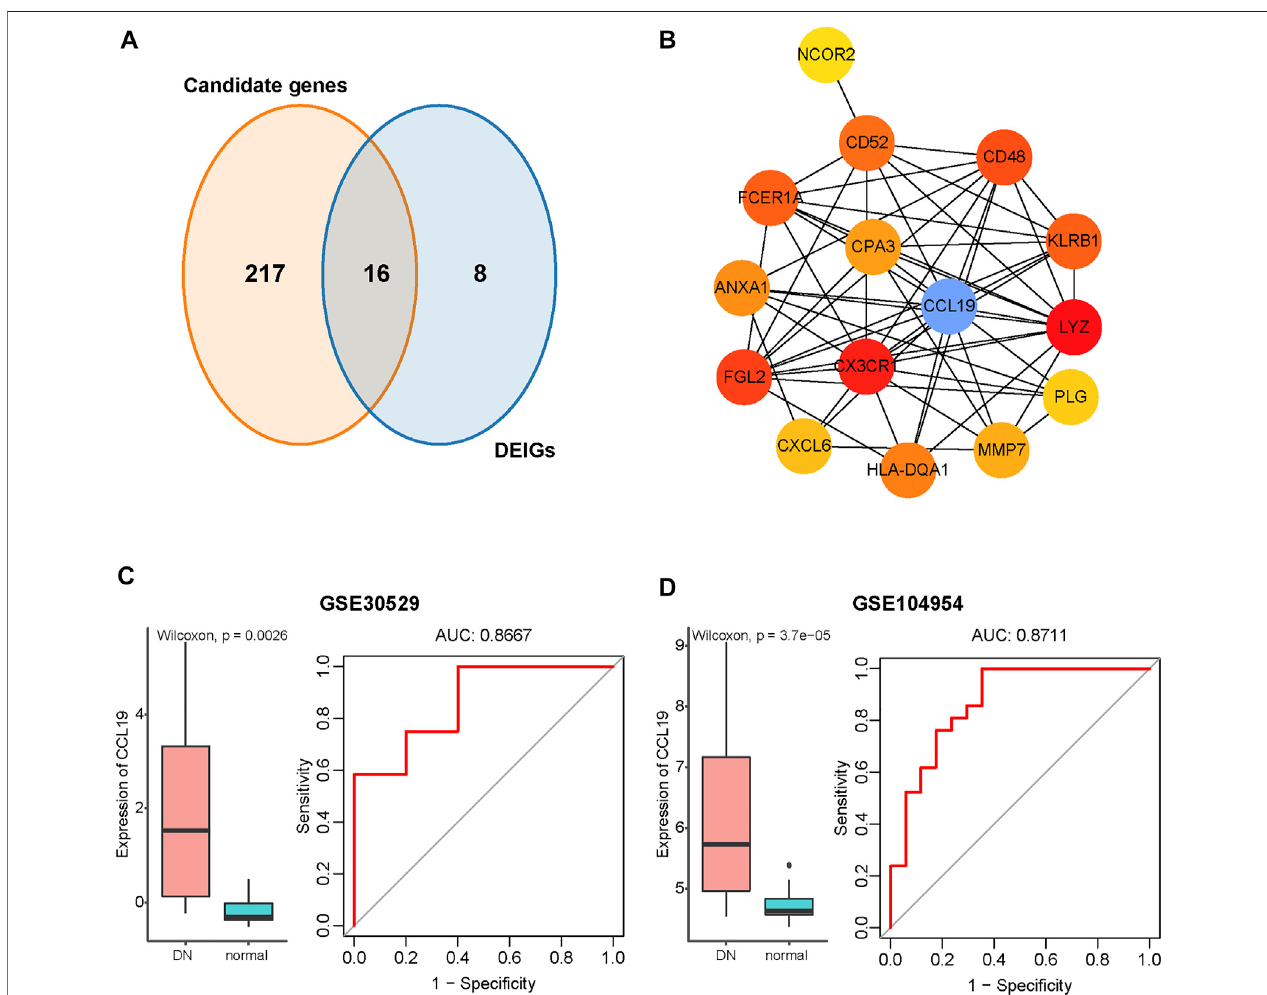
FIGURE 5 | Identi fi cation of CCL19 as a hub immune gene in DN and veri fi cation in the GSE30529 and GSE104954 datasets. (A) Venn diagram of DEGs and immune-related gene list. (B) PPI network of the overlapping genes between WGCNA and DEIG analysis. The gradients from yellow to red of each circle represent the increasingdegreeofcentrality.Thebluecirclerepresentsthehubwiththehighestdegreeofcentrality. (C) Veri fi cationofCCL19inGSE30529.Left:Boxplotshowingthe expression ofCCL19betweentheDN andhealthysamplesinGSE30529. TheWilcoxon rank-sumtest wasusedtomeasure thedifferences betweentwogroups. Right: ROC curve of CCL19 expression in DN. (D) Veri fi cation of CCL19 in GSE104954. Left: Boxplot showing the expression of CCL19 between the DN and healthy samples in GSE104954. The Wilcoxon rank-sum test was used to measure the differences between two groups. Right: ROC curve of CCL19 expression in DN.